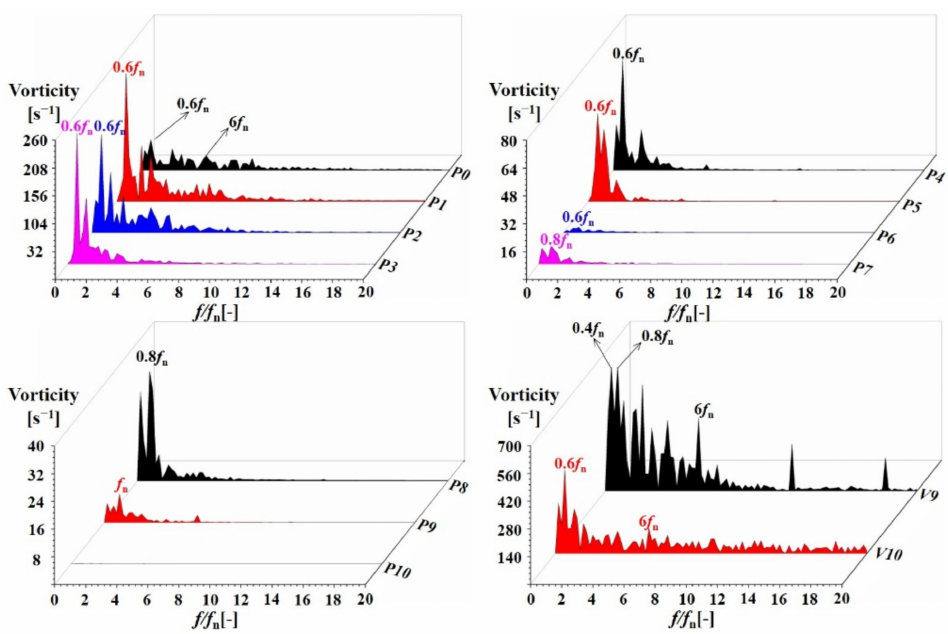
Figure 14. Frequency domain of vorticity fluctuation at the 0.7 Q b operation